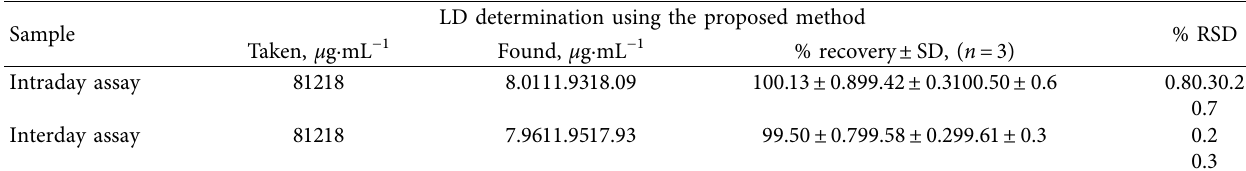
Table 5: Evaluation of the proposed method using intraday and interday